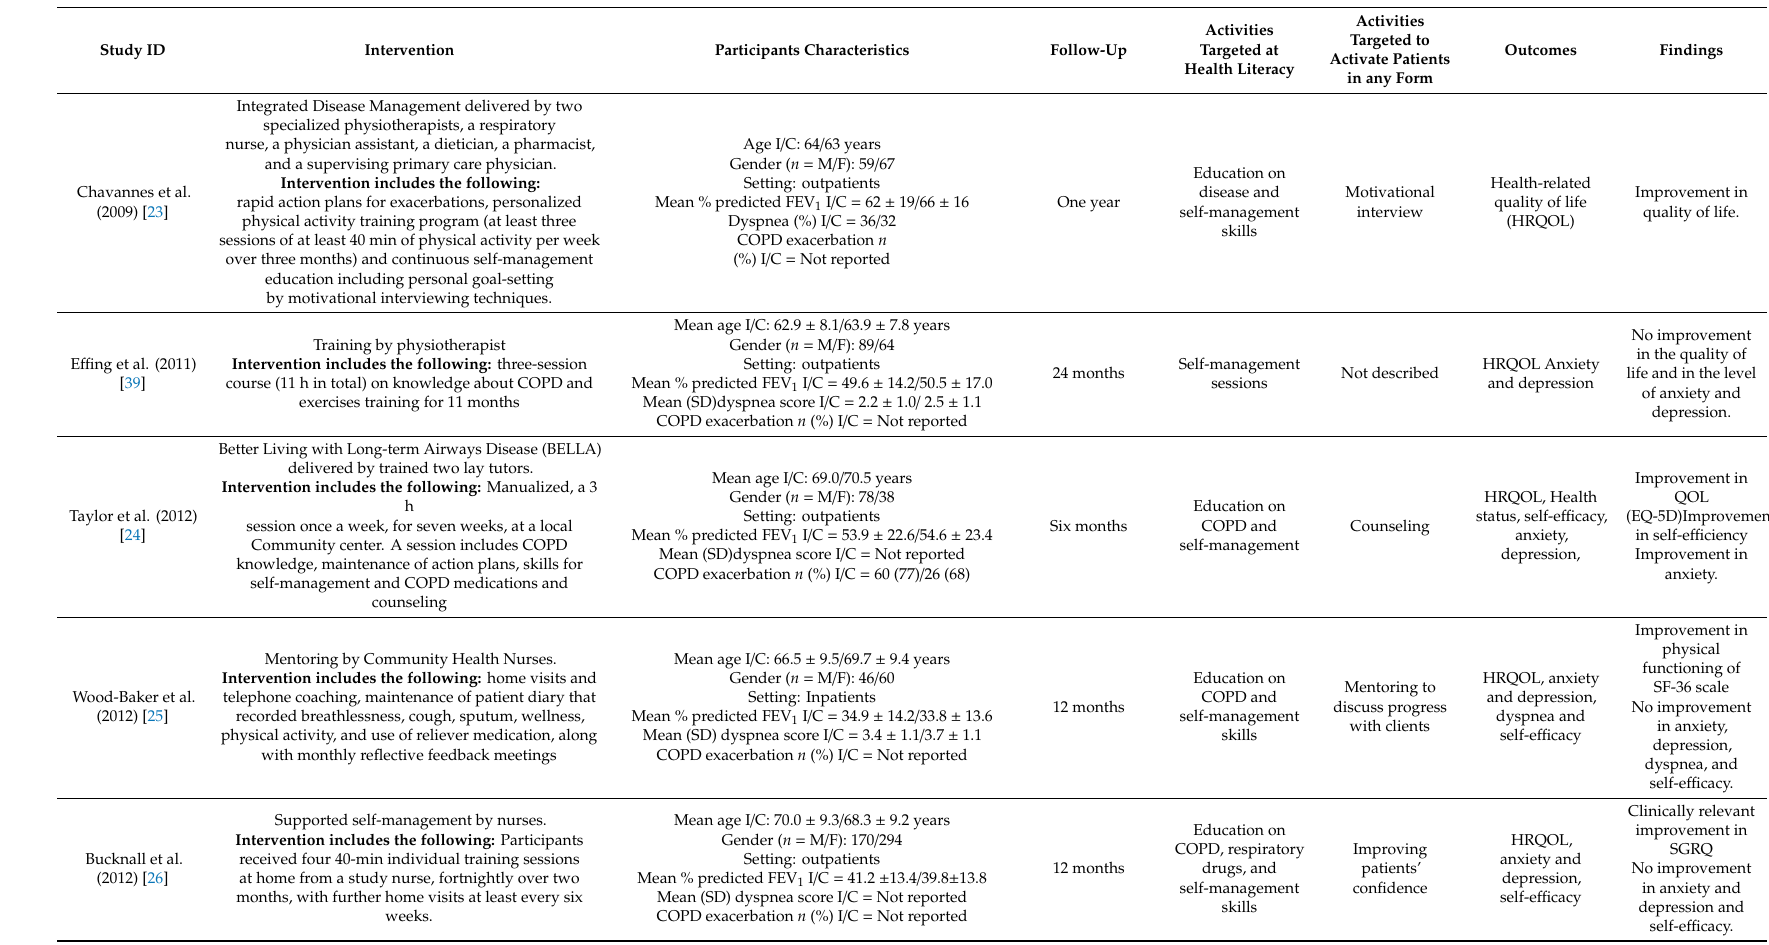
Table 1. Included